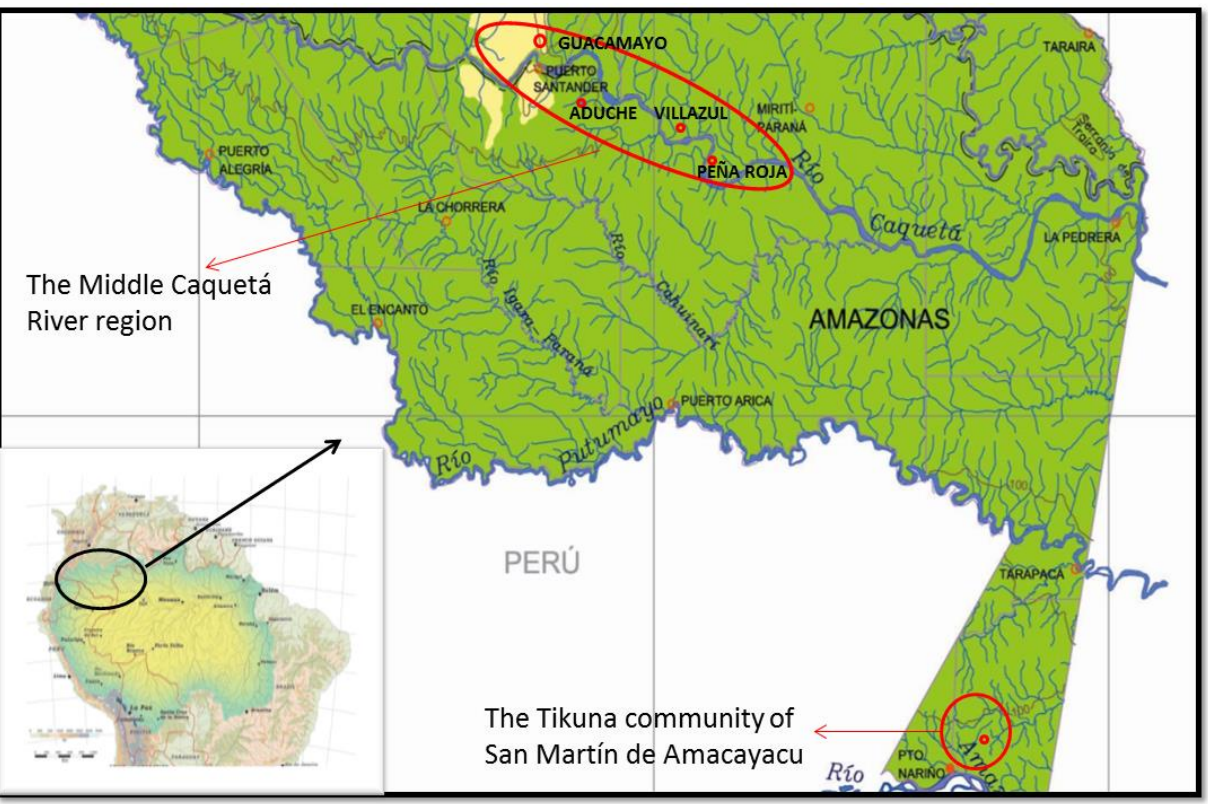
Figure 6. Map showing the two study areas where research was carried out. The map is based on the hydrographic map of the Amazon region (Sinchi 2002; scale